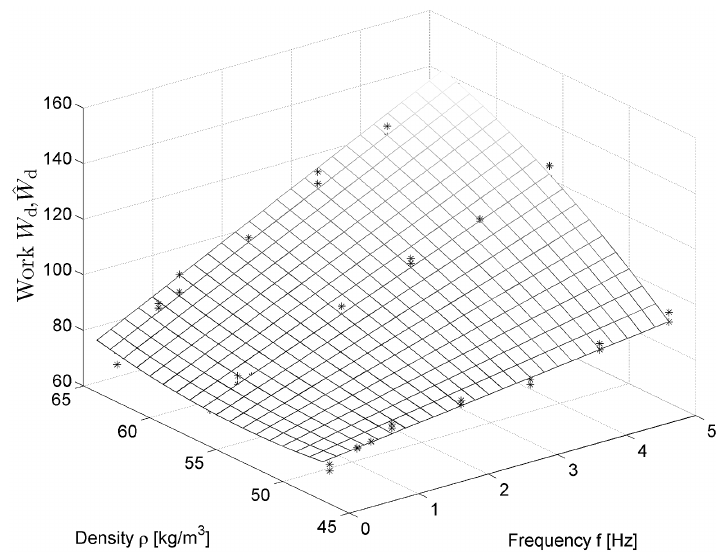
Fig. 5. Dependency of dissipation work of damping force W d on frequency f and material density ρ ( W d – measured values (*), ˆ W d - approximation